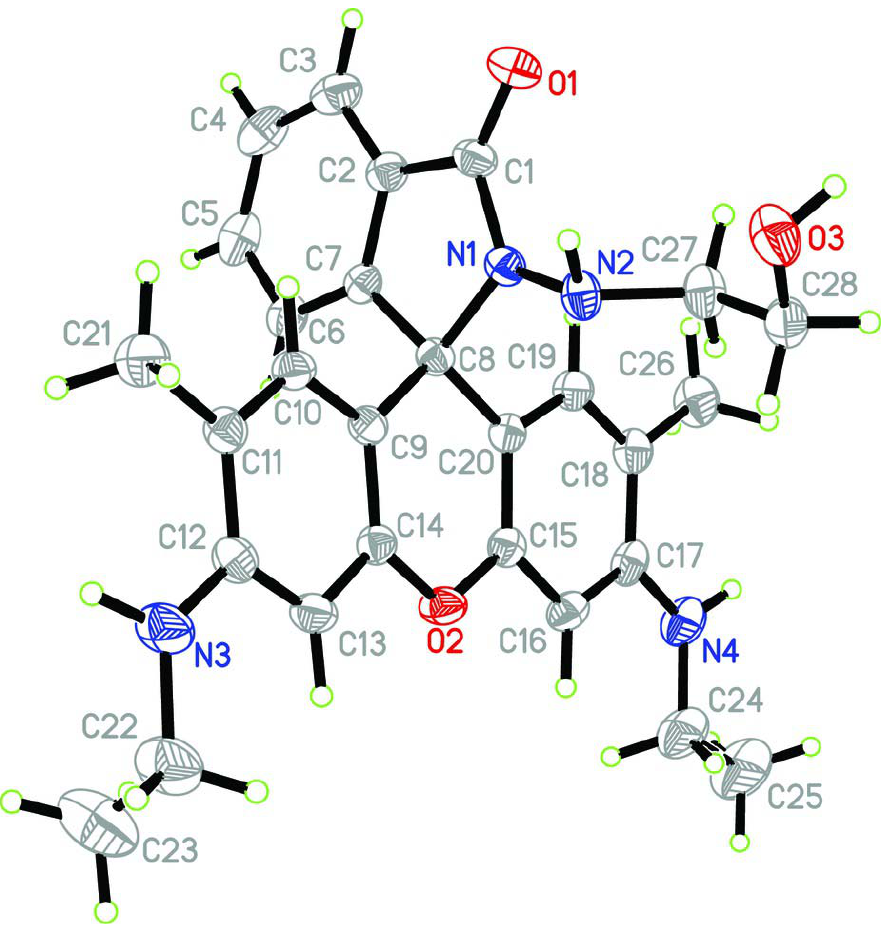
The structure of the title compound, showing the atom-numbering scheme and displacement ellipsoids at the 30% probability level. H atoms are represented as small spheres of arbitrary